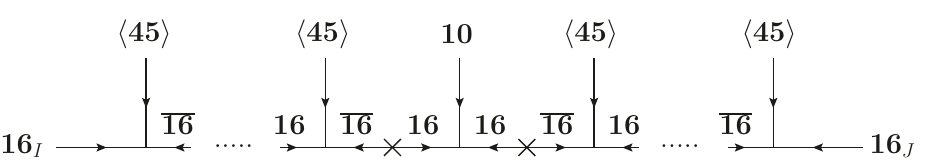
Figure 8 . A generic non-renormalizable superpotential operator of the form 16 I (cid:1) 16 J (cid:1) 10 (cid:1) 45 n + n 0